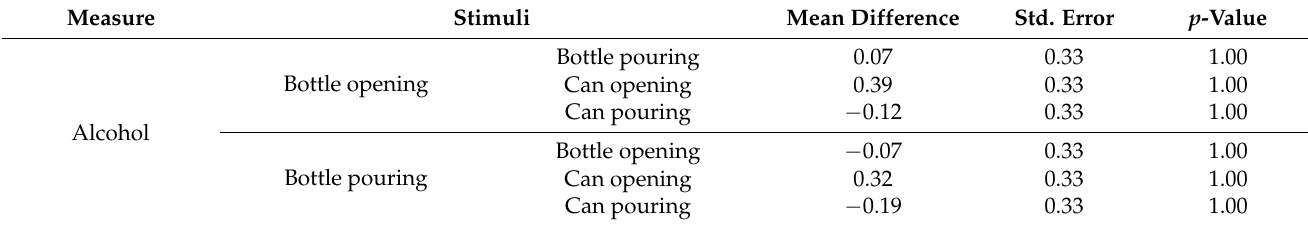
Table A4. Summary of the results of the pairwise comparisons of Experiment 1 between-participants condition (sounds of packaging auditory experience) for sensory